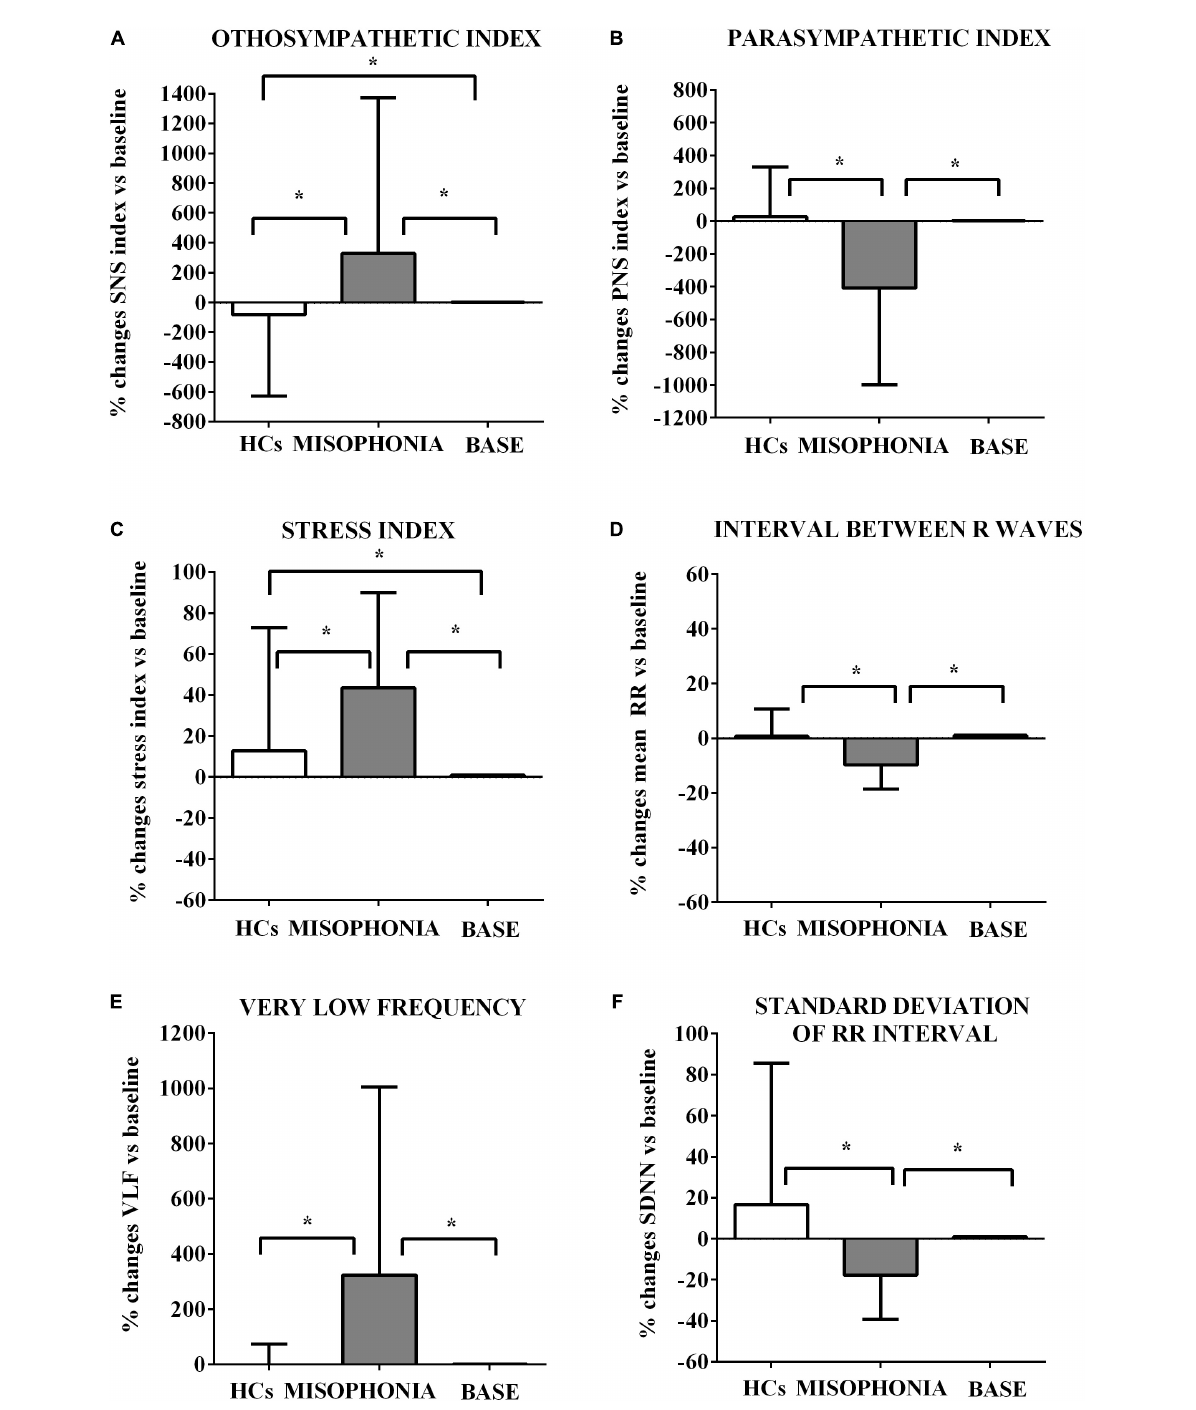
FIGURE3 Effects of the trigger sounds protocol on HRV variables in participants with misophonia and participants without misophonia [Healthy controls (HCs)] vs. specific baseline (set as 1). The results show increased orthosympathetic variables (SNS index, Stress index, and VLF) in participants with misophonia in comparison with values registered at the baseline. It is also to note that the parasympathetic variables (PNS index and mean RR) were decreased in participants without misophonia in comparison with values registered at baseline. SNS (A) , sympathetic; PNS (B) , parasympathetic; stress index (C) , stress index; RR (D) , interval the elapsed time between ECG R waves; VLF (E) , very low frequency; SDNN (F) , standard deviation of RR intervals. The results are the mean ± SE. The parentheses indicate significance between groups, as specified in Figure 2F . Various groups are represented as in Figure 2 . The statistical analysis between M and HCs was performed through the Mann–Whitney test, whereas the statistical analysis between M/HCs and baseline was performed through the Wilcoxon